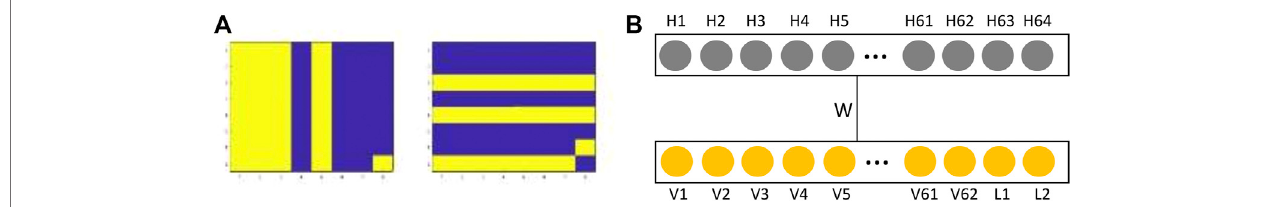
FIGURE 2 | (A) Example of the bars (left) and stripes (right) patterns of size 8 × 8. A blue cell represents a 0 while a yellow cell a 1. Last two bits (bottom right) are labels;bar (cid:2) 01,stripe (cid:2) 10. (B) RBMforclassi fi cation.Boxwithyellowunitsisthevisiblelayer.Thehiddenlayerisshownbyaboxwithgreyunits.8 × 8bitsofanimageis rearranged into a record of size 1 × 64 bits which is applied to the visible layer. Units L1 and L2 are the